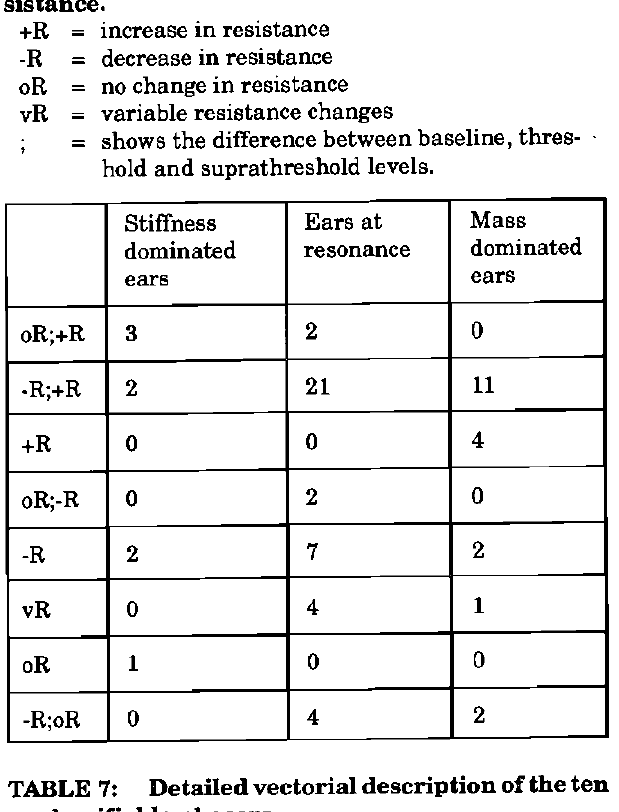
TABLE 6: Vector Analysis: Effect of the reflex on re-